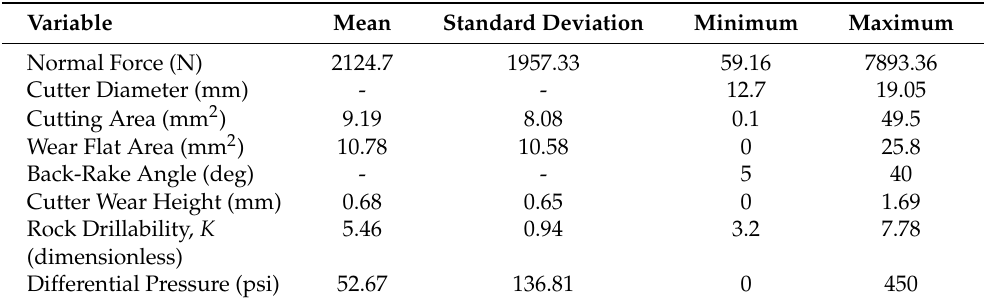
Table 3. Statistical summary of experimental data employed in regression of F a (Number of observa- tions 654).